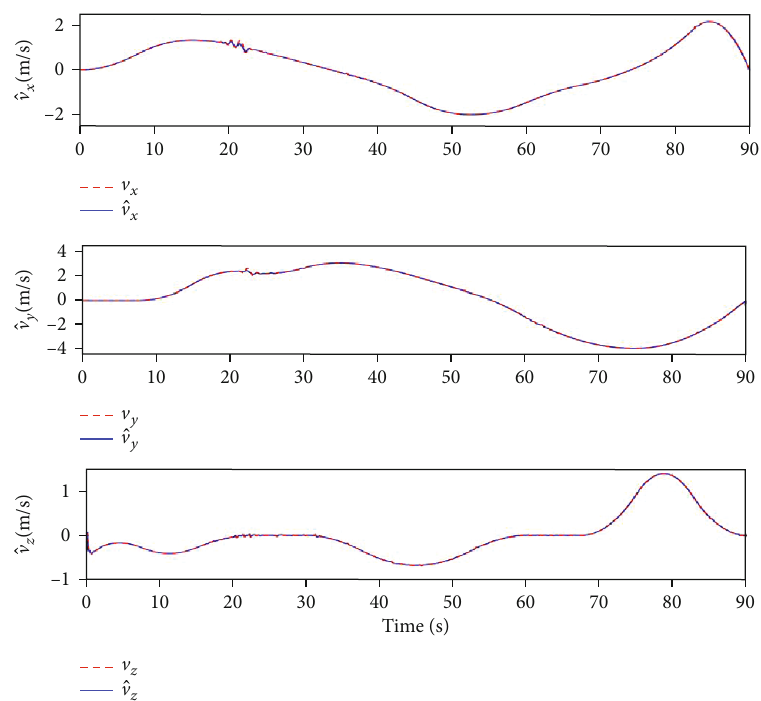
Figure 14: Pro fi les of the estimated velocities of the quadrotor ð ̂ v